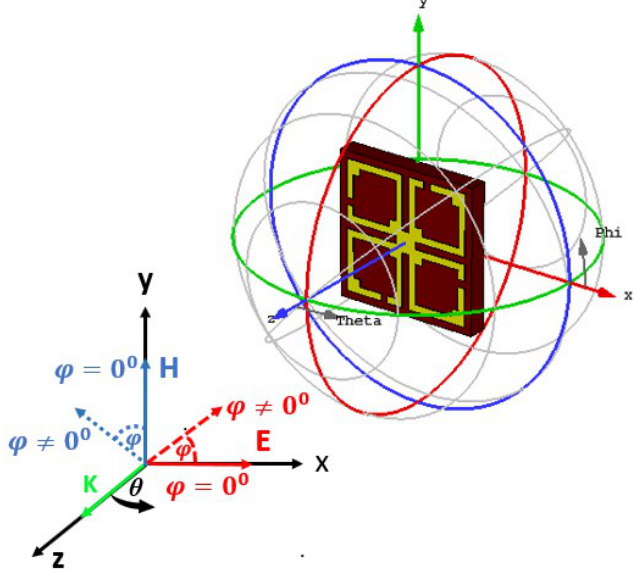
Figure 10. Polarization insensitivity at various angles of incidence.